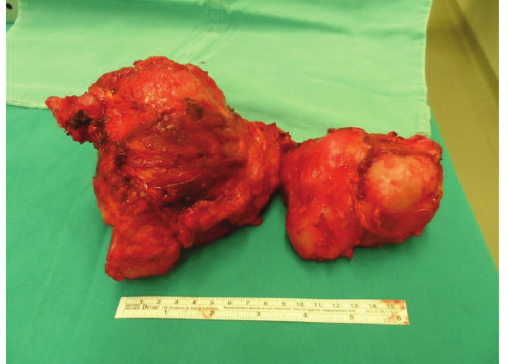
Figure 3: Excised tumor mass from the pelvic region.